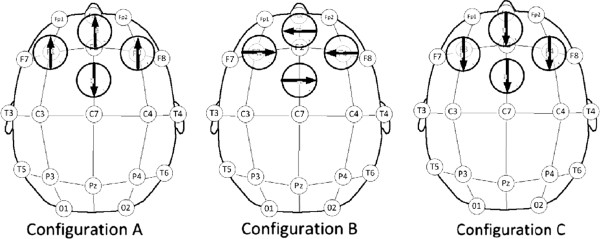
Representative PET scan images of one subject during noxious heat pain stimulation after sham (left side of the panel) and real (ride side of the panel) multi-coil rTMS treatment. The red arrow indicates the ACC region. After sham treatment activity in the ACC region seems to be increased by the noxious heat pain stimulus. After real multi-coil rTMS this activation was not observed.